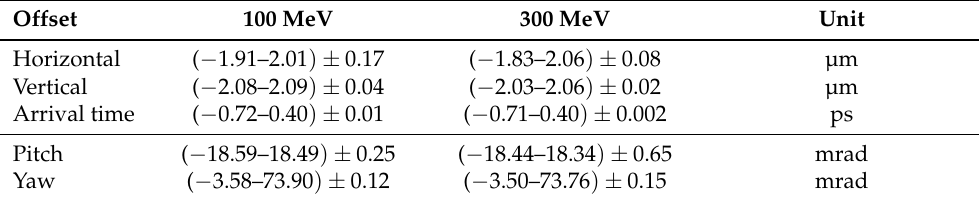
Figure 11. Laser offset scans of normalised flux in a 1.5mrad cone of the XLS-based source. ( a ) Scan of transverse offsets, horizontal and vertical. ( b ) Scan of longitudinal offset, expressed in terms of the arrival time. ( c ) Scan of angle offsets, pitch and yaw. The offset corresponding to the 2° crossing angle was marked with a dashed line. Table 6. Ranges of laser offset corresponding to a decrease of 5% in the flux in a 1.5mrad cone. Values are displayed for the XLS-based ICS source at an electron beam energy of 100MeV and 300MeV. Results were grouped by offset type.